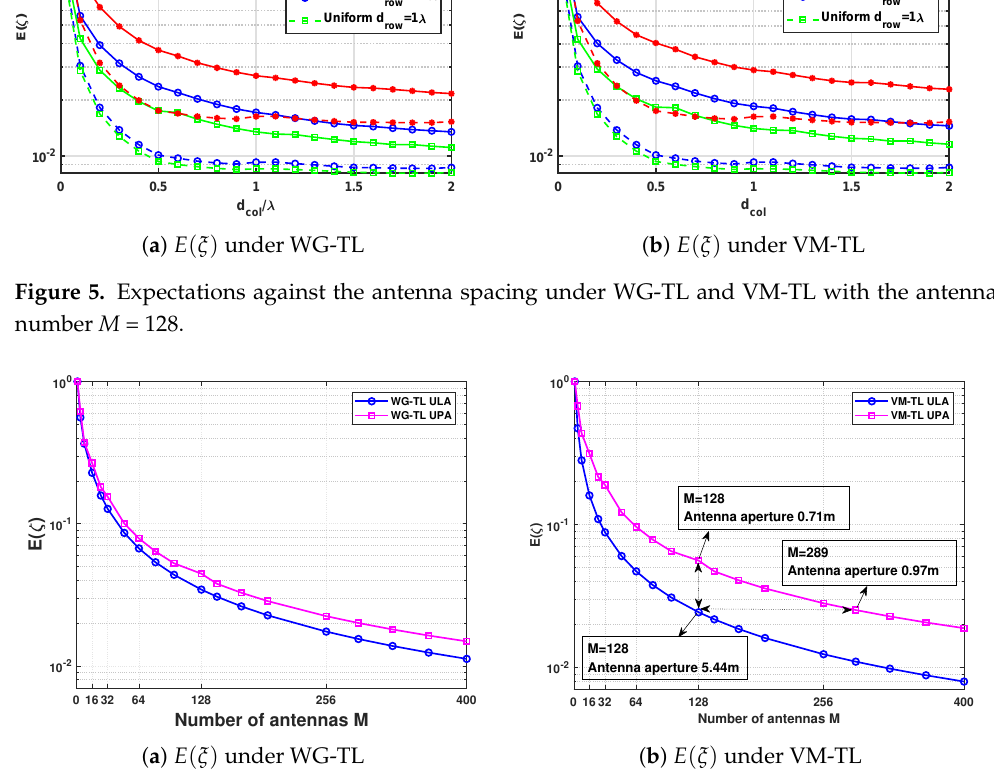
Figure 6. Expectations against the antenna number M under WG-TL and VM-TL with different antenna